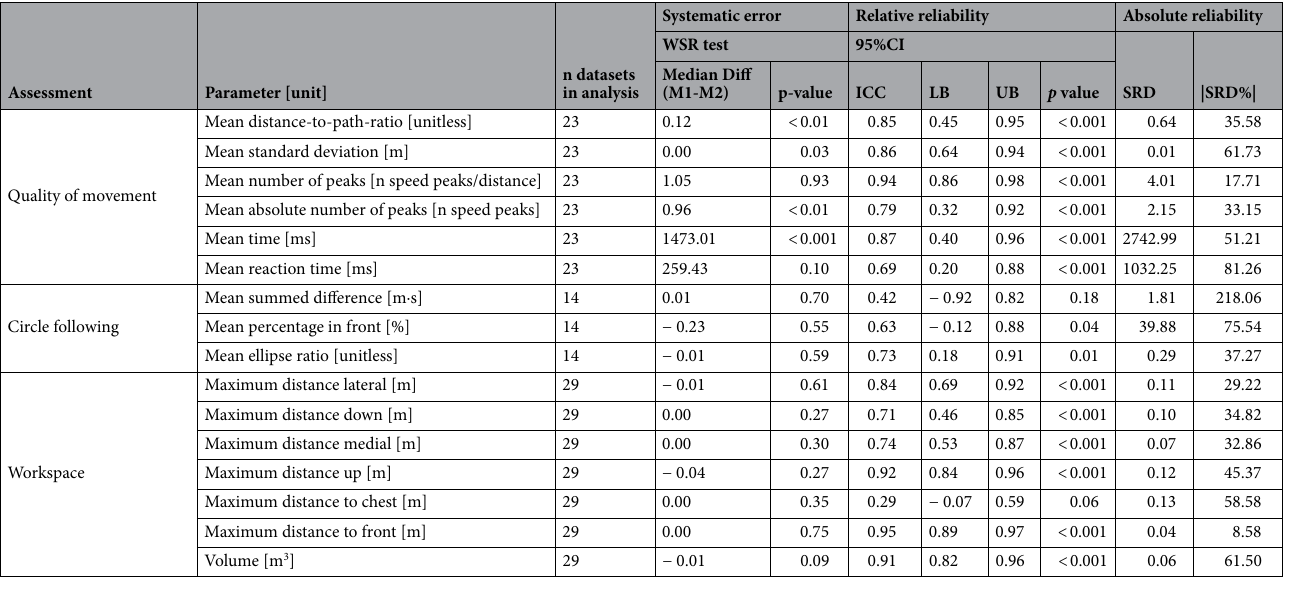
Table 2. Systematic error, relative and absolute reliability of the parameters of the ChARMin assessments. Results of the Wilcoxon signed-rank test (WSR test) investigating the systematic error. Displayed are all the 67 parameters of the assessments. Intraclass Correlation Coefficients of Quality of Movement and Circle assessment are based on average measures. Intraclass correlation coefficients of active and passive Range Of Motion, Strength, Resistance to Passive Movement and Workspace are based on single measures. Abbreviations: Diff. = difference; M1 = median of the first measurement; M2 = median of the second measurement; ICC = intraclass correlation coefficient; 95%CI = 95% confidence interval; LB = lower bound; UB = upper bound; SRD = smallest real difference; SRD% = smallest real difference/grand mean × 100. *A negative ICC is referred to as a bad or unfortunate estimate, possibly occurring by chance, especially with a small sample size 39